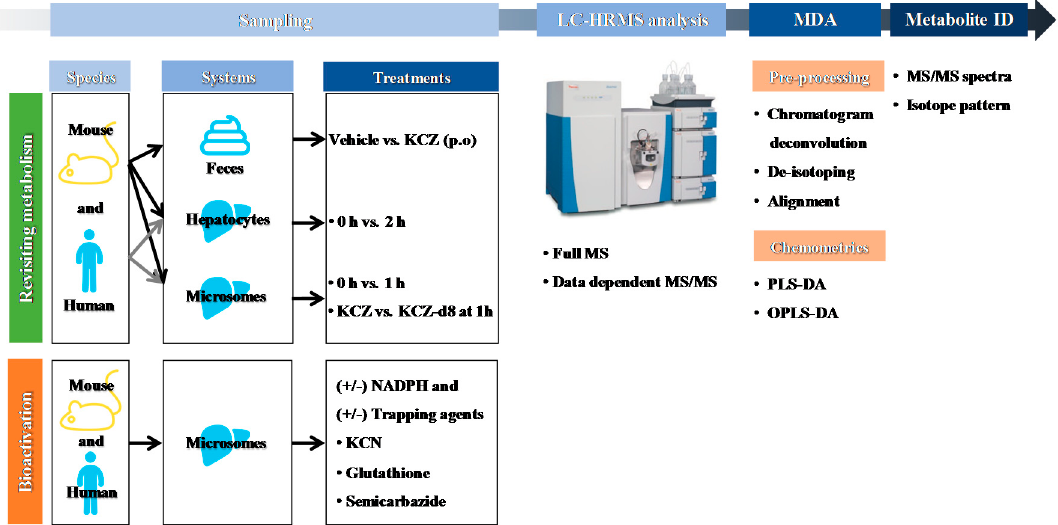
Figure 2. Schematic workflow for the metabolite profiling of ketoconazole using liquid chromatography–high resolution mass spectrometry (LC-HRMS)-based metabolomics. KCZ: ketoconazole, NADPH: reduced form of nicotinamide adenine dinucleotide phosphate, KCN: potassium cyanide, MS/MS: tandem mass spectrometry, MDA: multivariate data analysis, PLS-DA: partial least squares discriminant analysis, OPLS-DA: orthogonal partial least squares discriminant analysis.